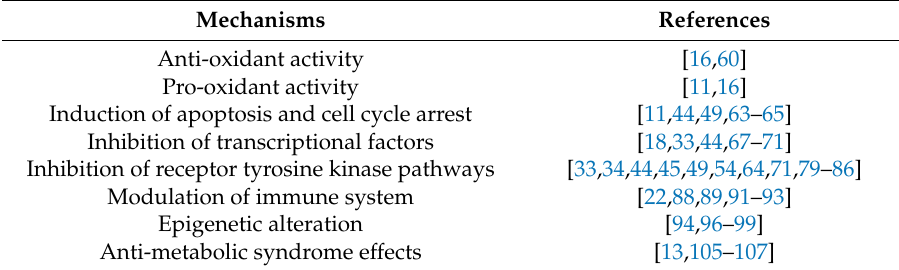
Table 1. Possible anti-cancer mechanisms of green tea catechins and their